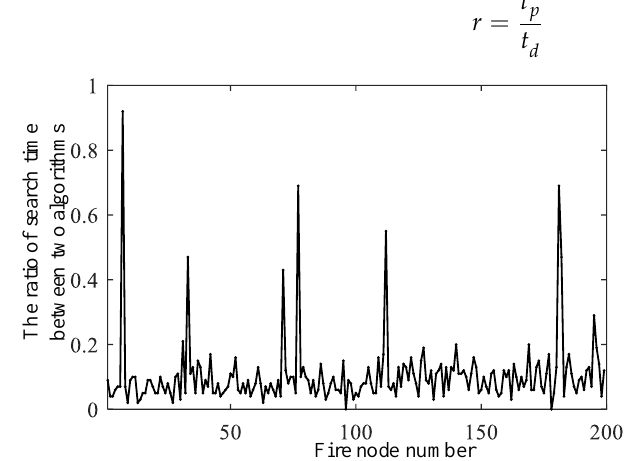
Figure 12. Ratio r of online search time t p and t